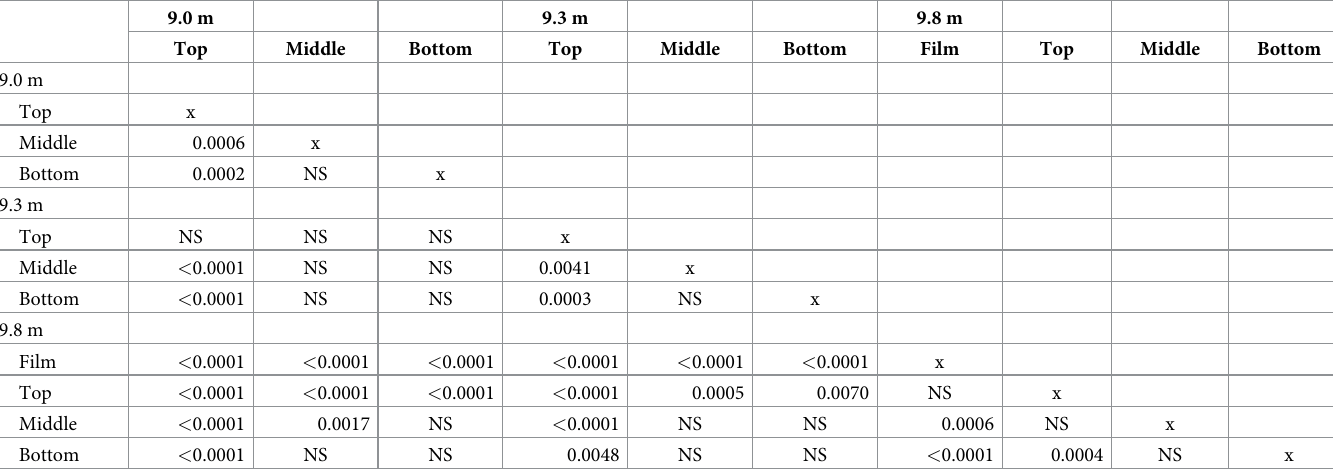
Table 3. Gene family alpha